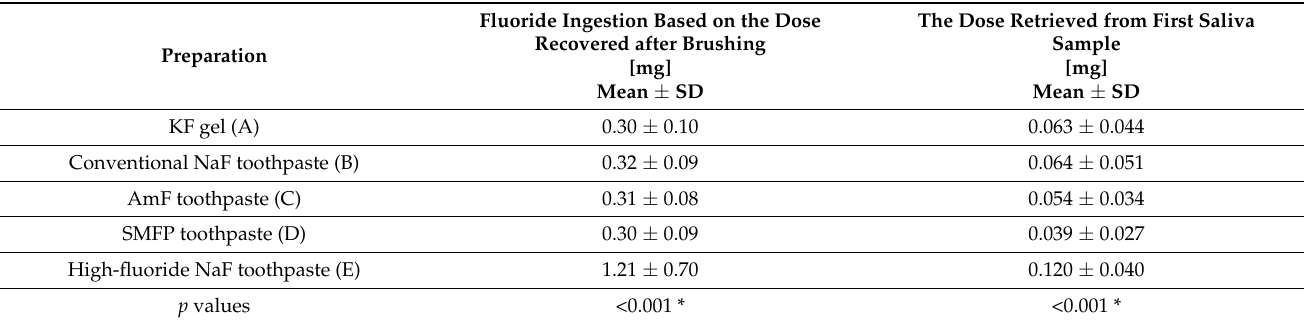
Table 3. Fluoride ingestion [mg] based on the dose retrieved after brushing and fluoride retrieved from saliva after